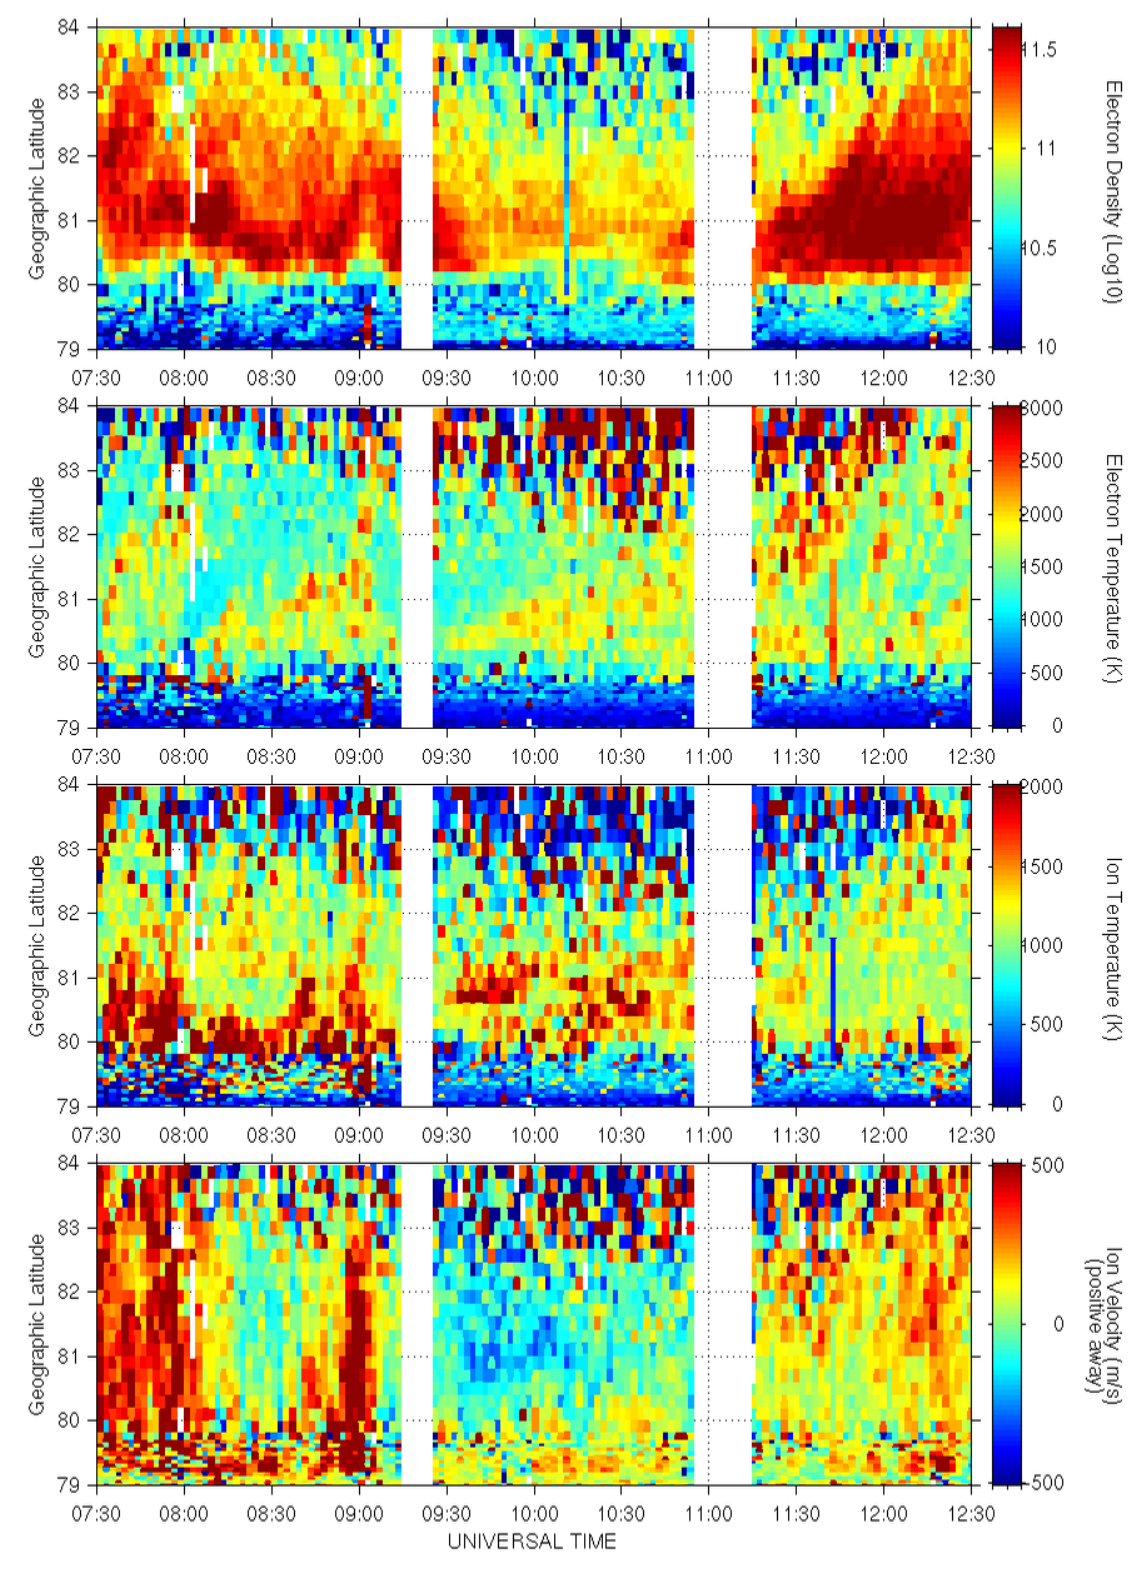
Fig. 4. Plasma parameters measured by the northward pointing ESR dish on 2February2001. From top to bottom: N e , electron density, T e , electron temperature, T i , ion temperature, and line-of-sight velocity, V i as a function of time and geographic